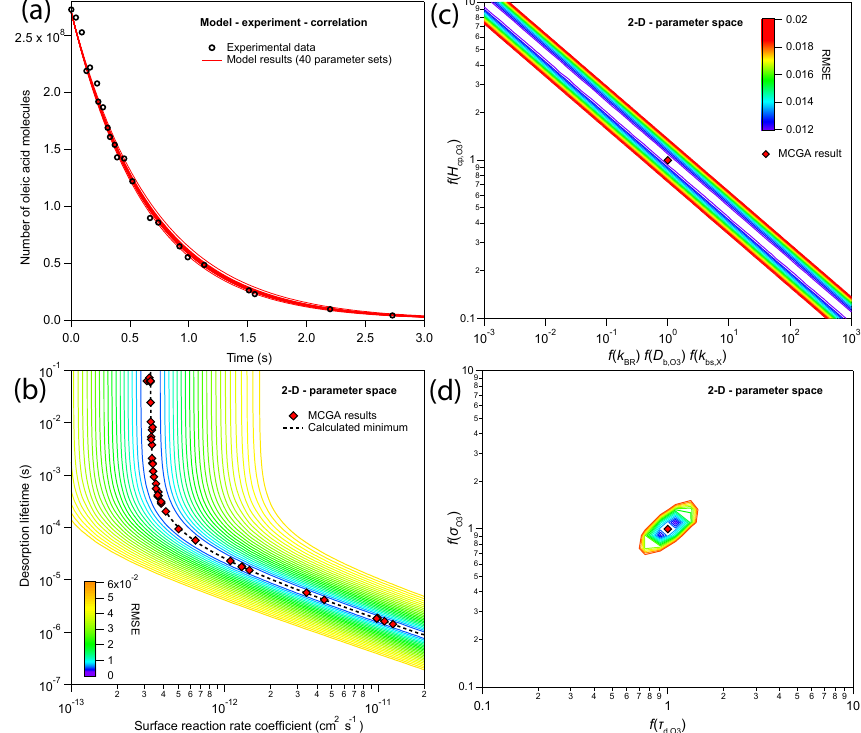
Figure 3. (a) Results from repeatedly fitting a kinetic model to a single experimental decay curve (adopted from Hearn et al., 2005). MCGA was used to optimize two model parameters, a surface reaction rate coefficient and the desorption lifetime of the gas-phase oxidant. All other model parameters remained fixed. (b) Visualization of the MCGA findings on the two-dimensional optimization hypersurface. The hypersurface (contour lines represent the root mean square deviances) exhibits no unique minimum due to insufficiently broad experimental data and optimization result (red diamonds) scatter along the extended minimum (black dashed line). Panels (c) and (d) show exemplary optimization hypersurfaces with two parameters showing an elongated (c) or a distinct minimum (d) . Panels (c) and (d) are reproduced from Berkemeier et al. (2016) with permission from the PCCP Owner